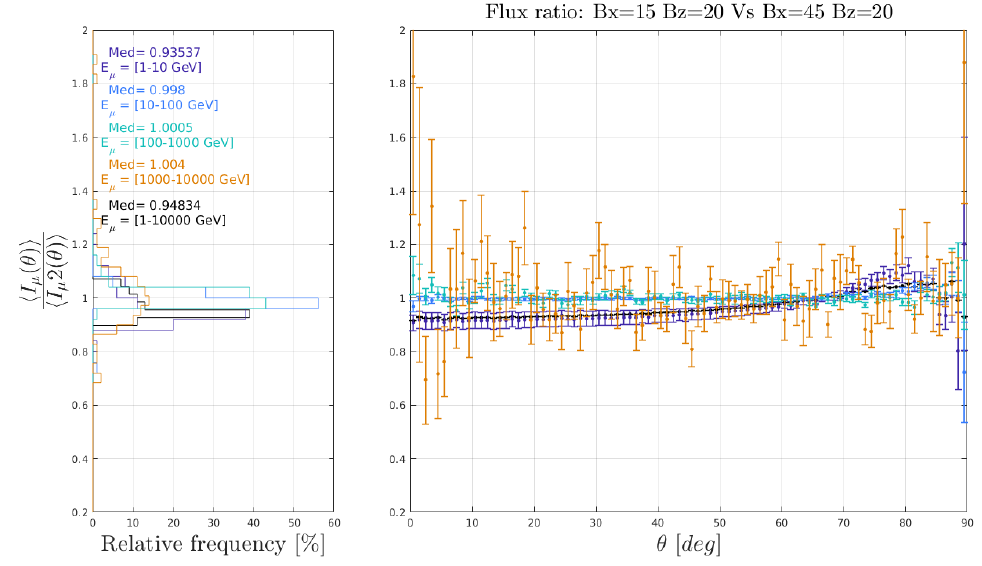
Figure 9. Comparison of two simulations, with same atmosphere and altitude, and different magnetic fields. The magnetic parameters are (1) B x = 15 µT, B z = 20 µT and (2) B x = 45 µT, B z = 20 µT. The latter is the reference flux (denominator). ( Left panel ) Histogram of flux ratio values computed over the zenith angle range (details are shown in the right figure) for different energy ranges from 1 to 10 4 GeV (in color) and for the whole energy range (in black). ( Right panel ) Flux ratio dependence on the zenith angle θ between two different magnetic field fluxes for the same energy ranges as in the left panel. Med corresponds to the median value in each energy